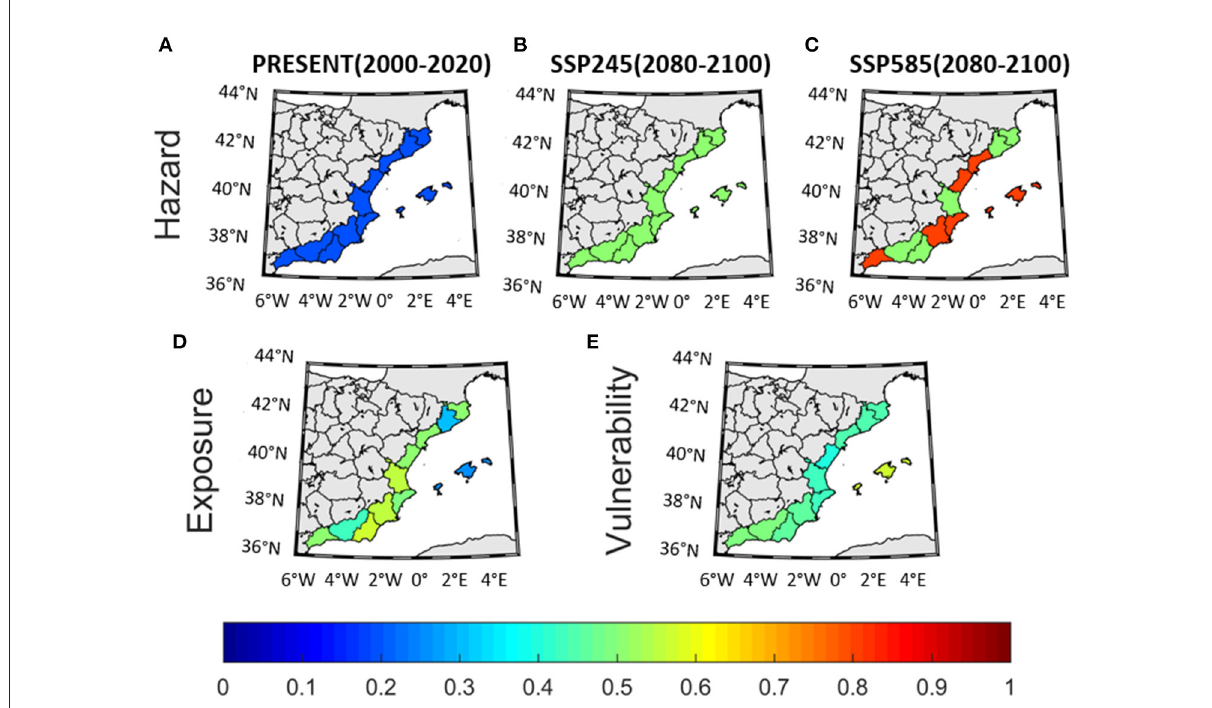
FIGURE6 Aggregated indicators for impact chain 1, corresponding to the “Risk of loss of attractiveness due to an increase in the heat stress”. (A) Hazard value in present conditions (200–2020), (B) at the end of the century (2080–2100) under SSP245 and (C) under SSP585. (D) Exposure and (E) Vulnerability. Note that (D,E) have the same values for present and